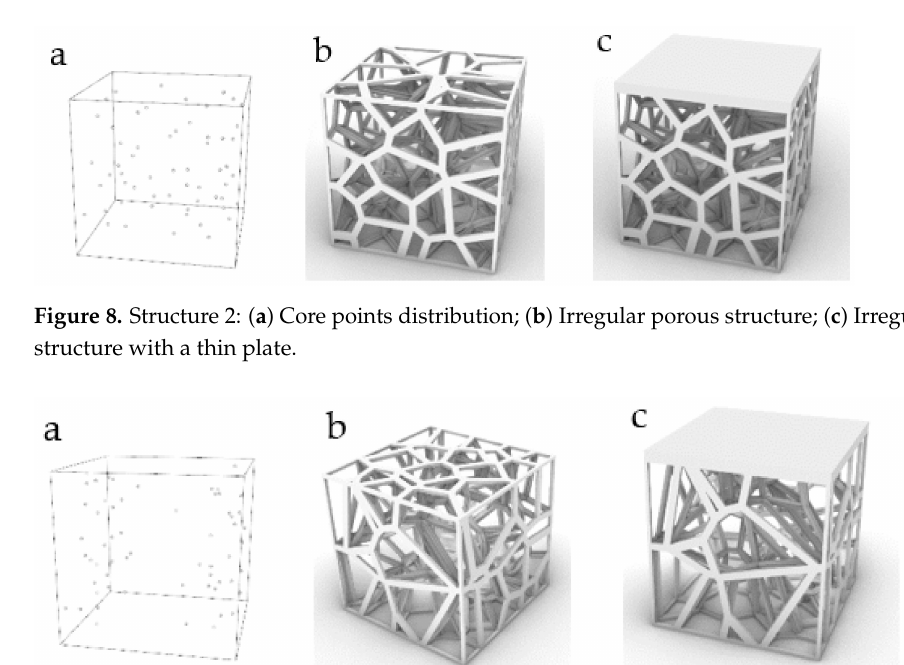
Figure 7. Structure 1: ( a ) Basic unit cell; ( b ) Regular porous structure; ( c ) Regular porous structure with a thin plate.